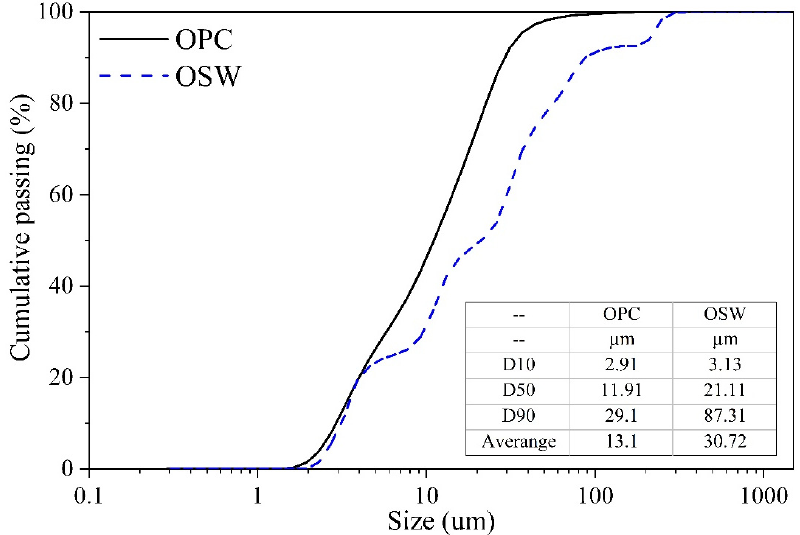
Figure 4. Particle size distribution of OPC and OSW.